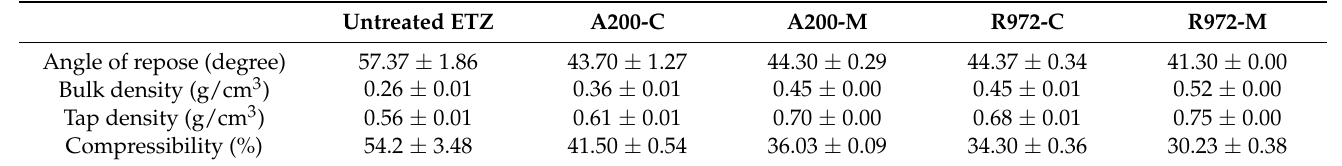
Table 1. Powder flowability parameters of silica nanoparticle-coated ETZ measured by a Hosokawa powder tester. Data are presented as means ± standard deviations ( n =